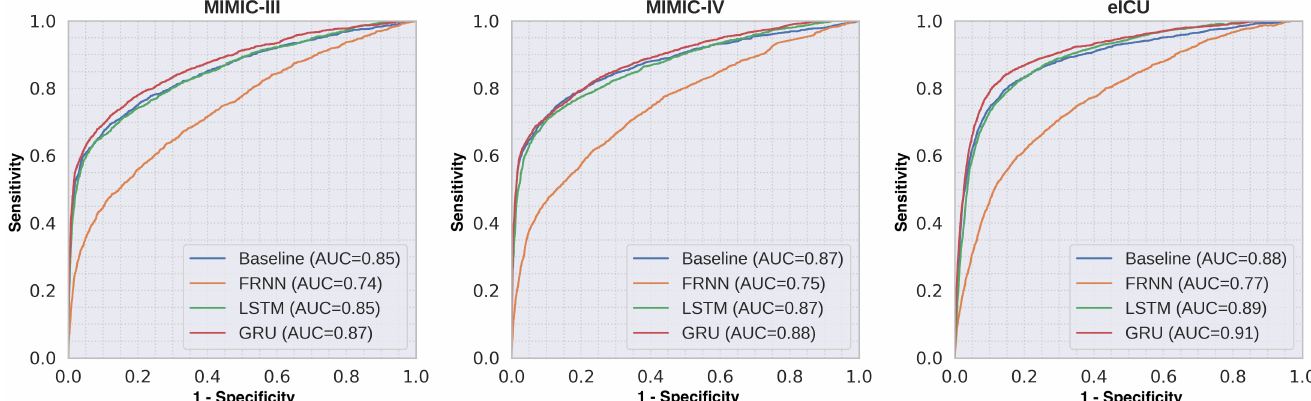
Figure 4. ROC curves comparing different RNN models trained on all variables for each database with the 48-h observation window. The GRU models had the highest AUCs. Similar trends were observed across different databases. Table 4. Classification performance measures of the GRU model with a 48-h observation window (T O = 48). Variables